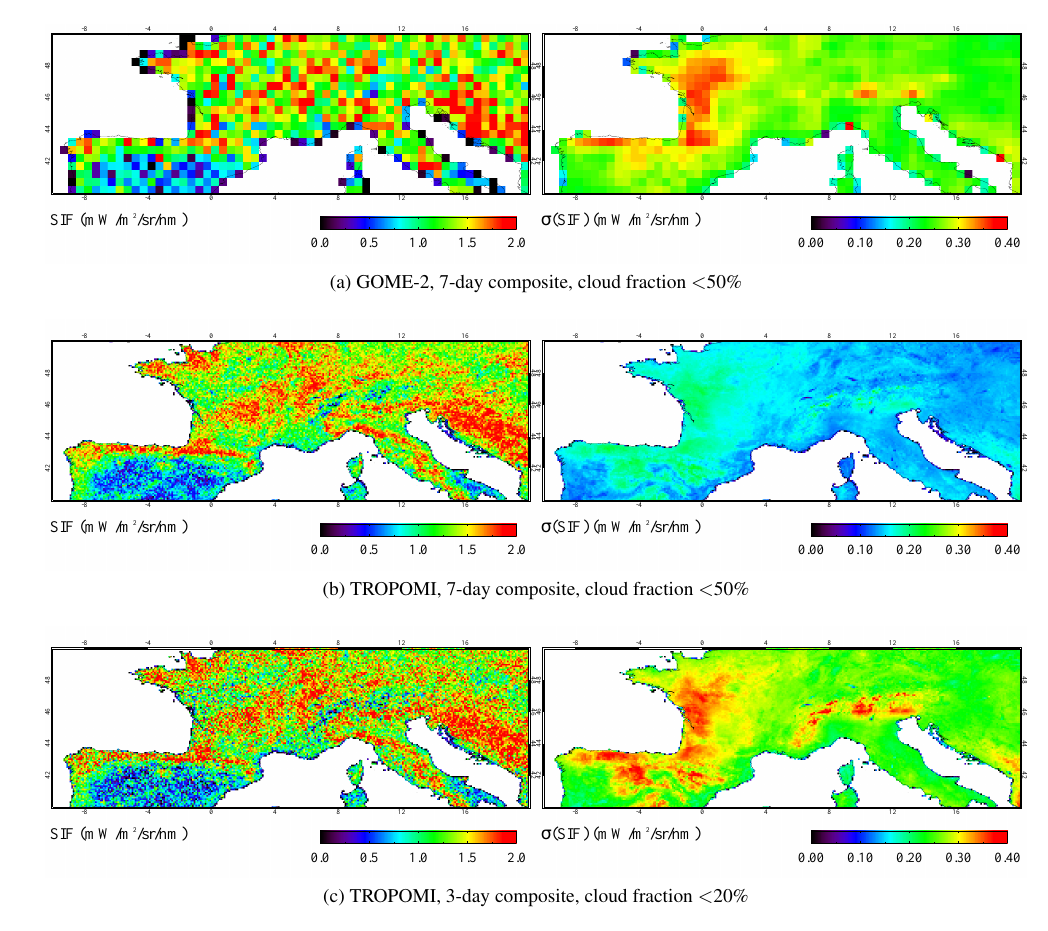
Figure 12. Composites of mean SIF and standard error of the mean ( σ (SIF)) for the 735–758nm fitting window in July from GOME-2 and TROPOMI for an area in western Europe (40–50 ◦ N, − 10–20 ◦ E). Simulated clear-sky composites are for a 7-day average and a cloud fraction < 50% for both GOME-2 and TROPOMI, and additionally also for a 3-day average and a cloud fraction < 20% for TROPOMI. measurements and satellite-based data sets (Guanter et